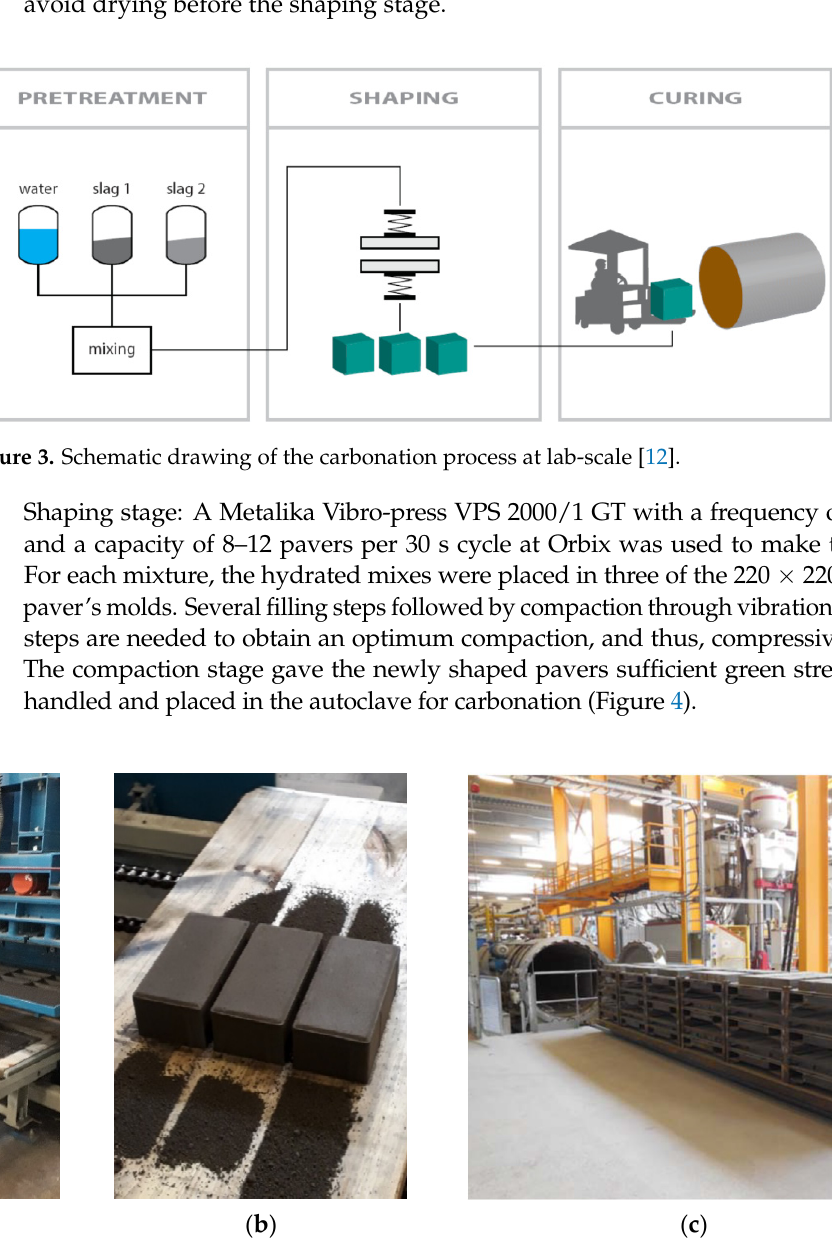
Figure 4. ( a ) Metalika vibro-press used to make the pavers at the Orbix site in Farciennes; ( b ) Pavers before carbonation; ( c ) Scholtz CO 2 autoclave at the Orbix site.